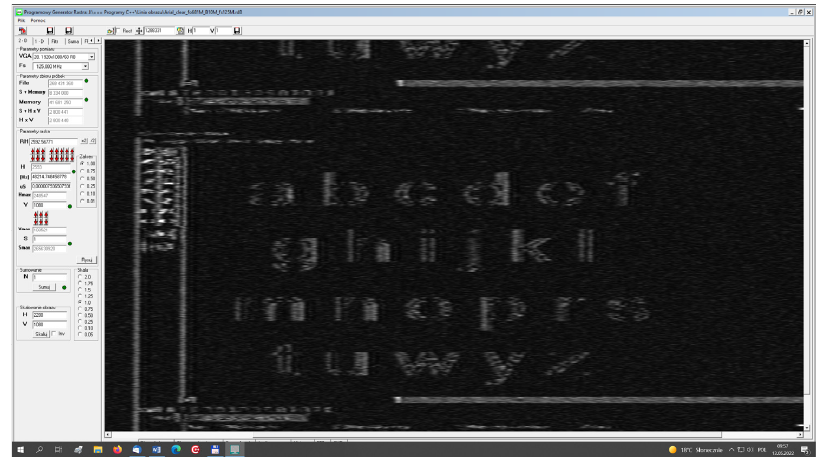
Figure 7. A window of Raster Generator with an exemplary reconstructed image based on a recorded revealing signal.